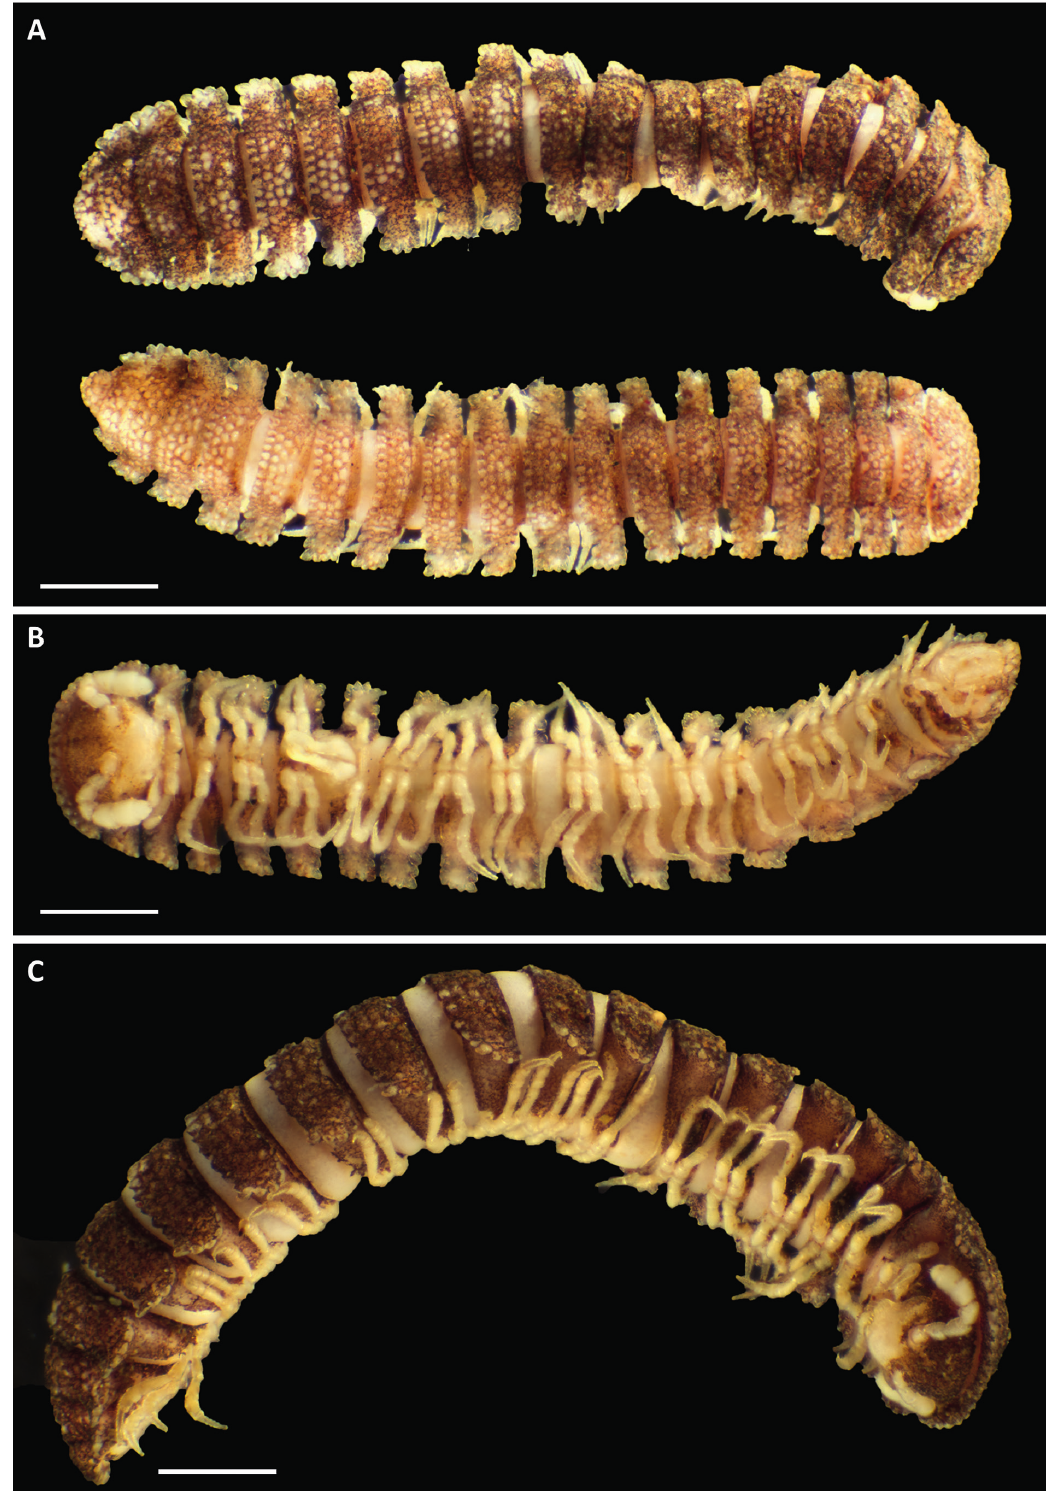
Fig. 12. Elythemus enghoffi Hoffman, 1978, specimens from Uluguru Mts, at Bunduki Village. A . 2 ♂♂ (NHMD 621814), dorsal view. B . ♂ (NHMD 621814), ventral view. C . ♀ (NHMD 621814), lateral view. Scale bars = 1 mm. Photo: S.G.